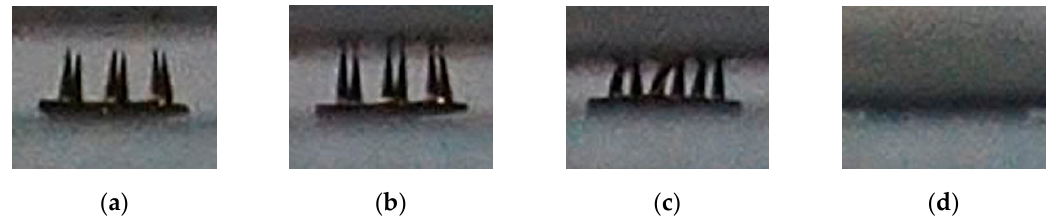
Figure 5. The side face picture of pressing process: ( a ) before contraction; ( b ) tip contact the sensor; ( c ) the needle deformed under the pressure; and ( d ) the MNs was crushed totally.